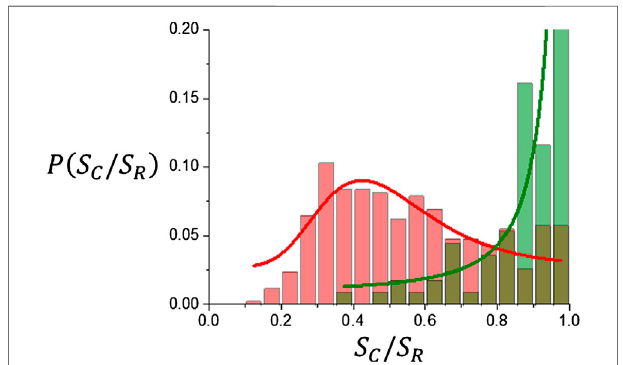
FIGURE 9 | Distribution histograms for S C / S R . Meningiomas and acoustic schwannomas are indicated in green and gliomas in red.